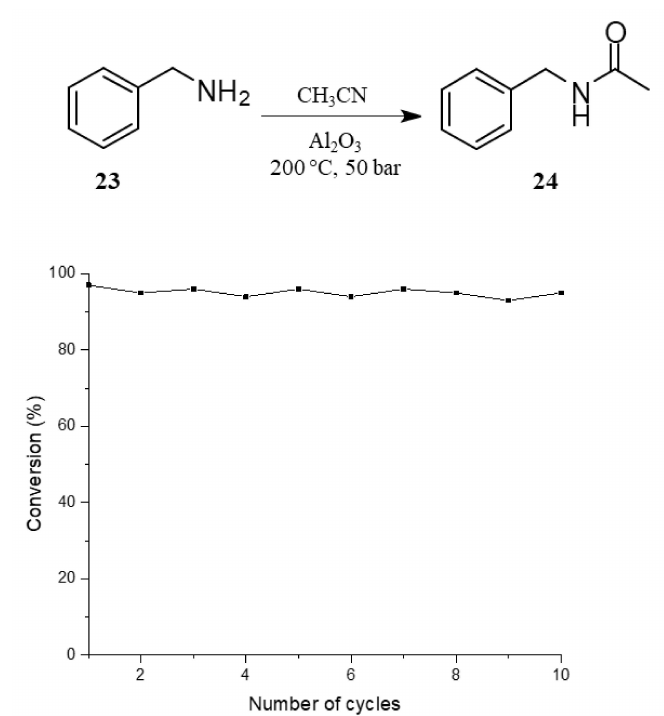
Figure 3. Robustness of the acetylation investigated in the reaction of benzylamine. The same reaction was repeated 10 times on the same catalyst.